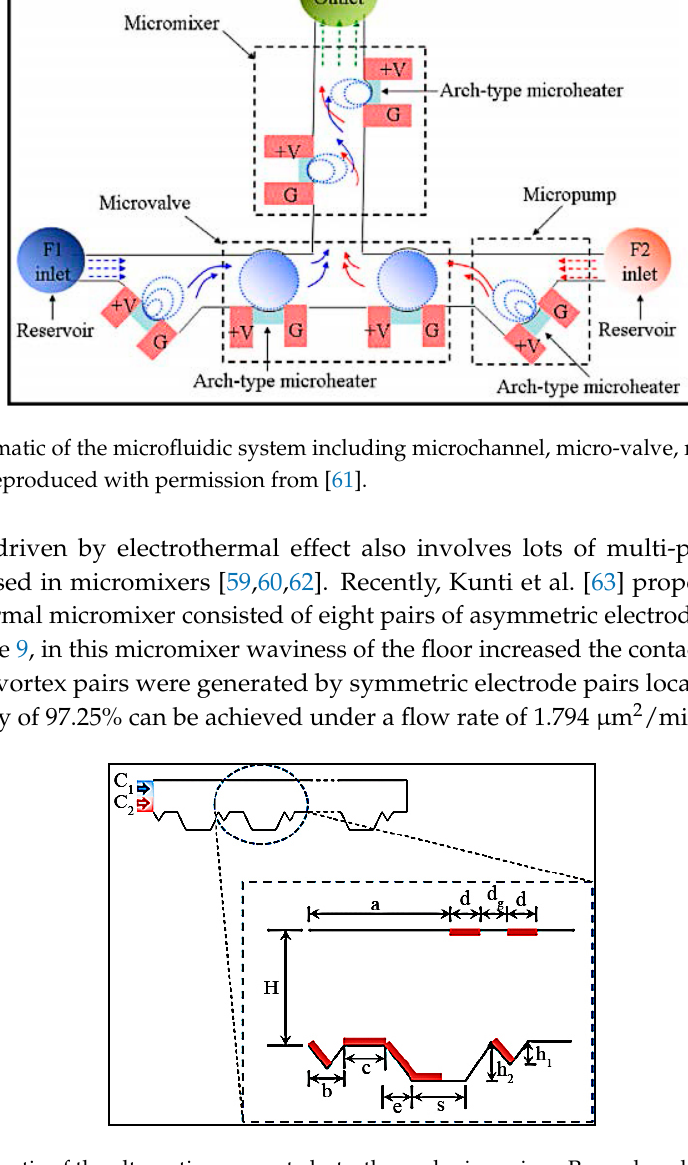
Figure 9. Schematic of the alternating current electrothermal micromixer. Reproduced with permission from [63].